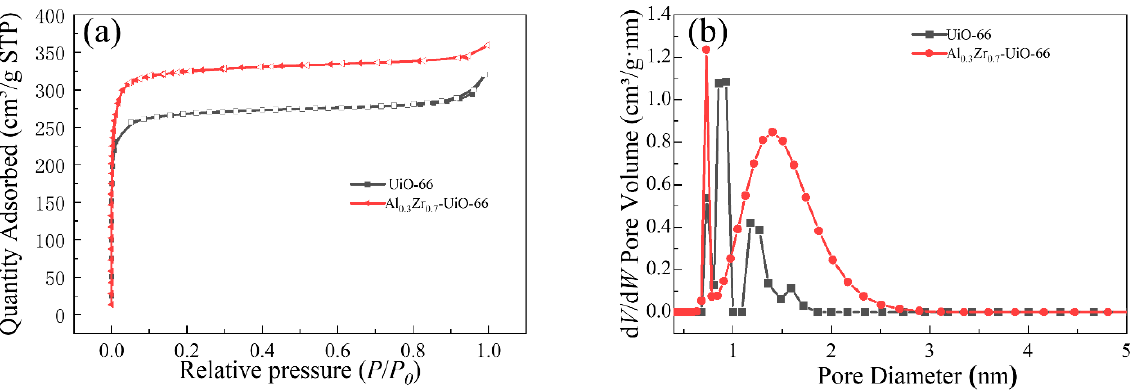
Figure 4. ( a ) N 2 adsorption-desorption isotherms and ( b ) DFT-calculated pore size distributions of UiO-66 and Al 0.3 Zr 0.7 -UiO-66. Table 1. Textural properties of UiO-66 and Al 0.3 Zr 0.7 -UiO-66.